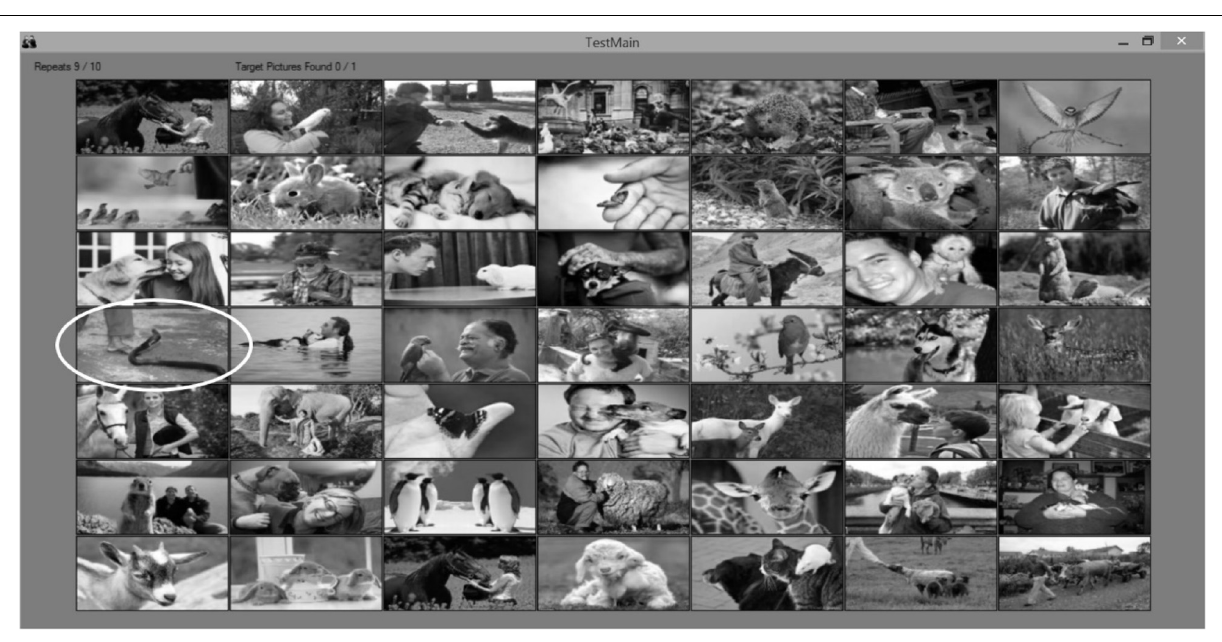
(see Table 1 ), we have detected no significant differences (and low effect sizes: Cohen’s ds lower or equal to